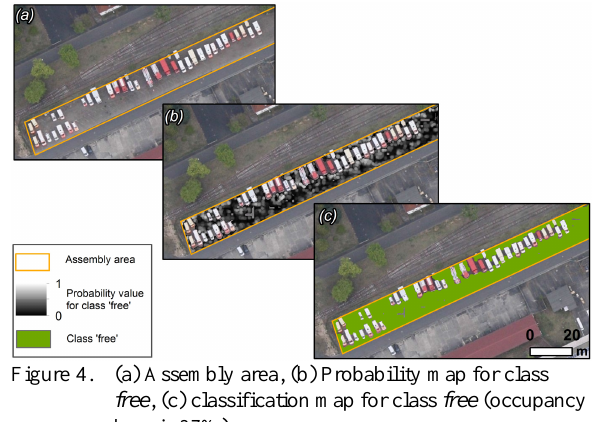
Figure 4. (a) Assembly area, (b) Probability map for class free , (c) classification map for class free (occupancy here is 37%).